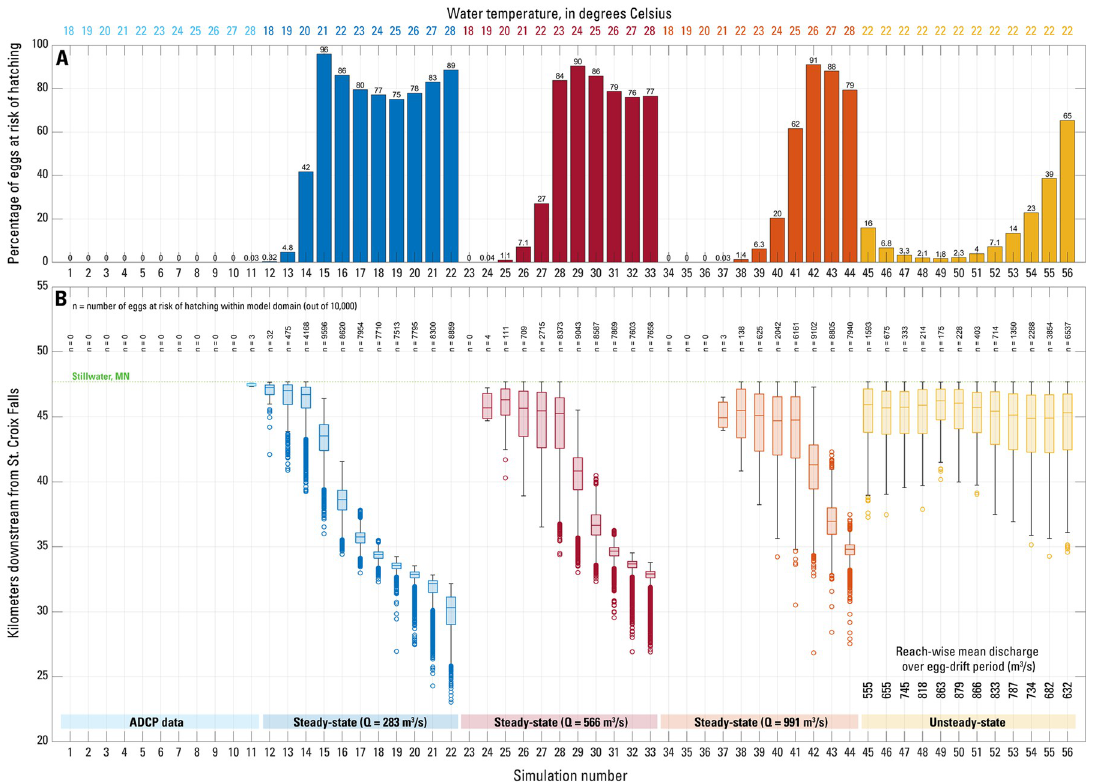
Fig 4. Results of the 56 FluEgg simulations listed in Table 1 for hypothetical bighead carp spawning on the lower St. Croix River. (A) Percentage of eggs spawned at St. Croix Falls, Wisconsin, at risk of hatching within the study reach. (B) Boxplots showing the streamwise distribution of the eggs at risk of hatching for each simulation at the time of egg hatching. The number of eggs at risk of hatching (n) is shown above each boxplot. The reach-wise mean discharge averaged over the egg drift period (spawning to hatching) for each unsteady simulation are shown for reference. No data are shown for eggs that have passed Stillwater, Minnesota, and left the model domain. The box and whiskers from bottom to top represent the nonoutlier minimum value, lower quartile, median value, upper quartile, and nonoutlier maximum value. Outliers are denoted by open